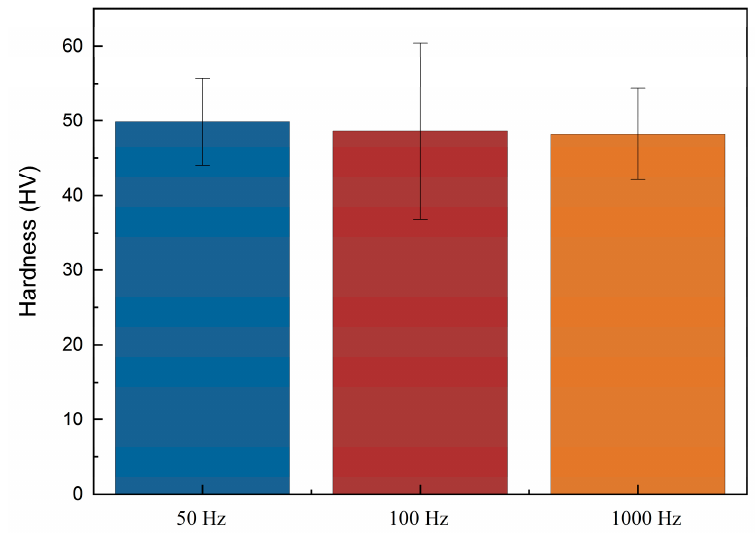
Figure 7. Bar chart of Vickers hardness of electrodeposited zinc under 50 Hz, 100 Hz, and 1000 Hz.